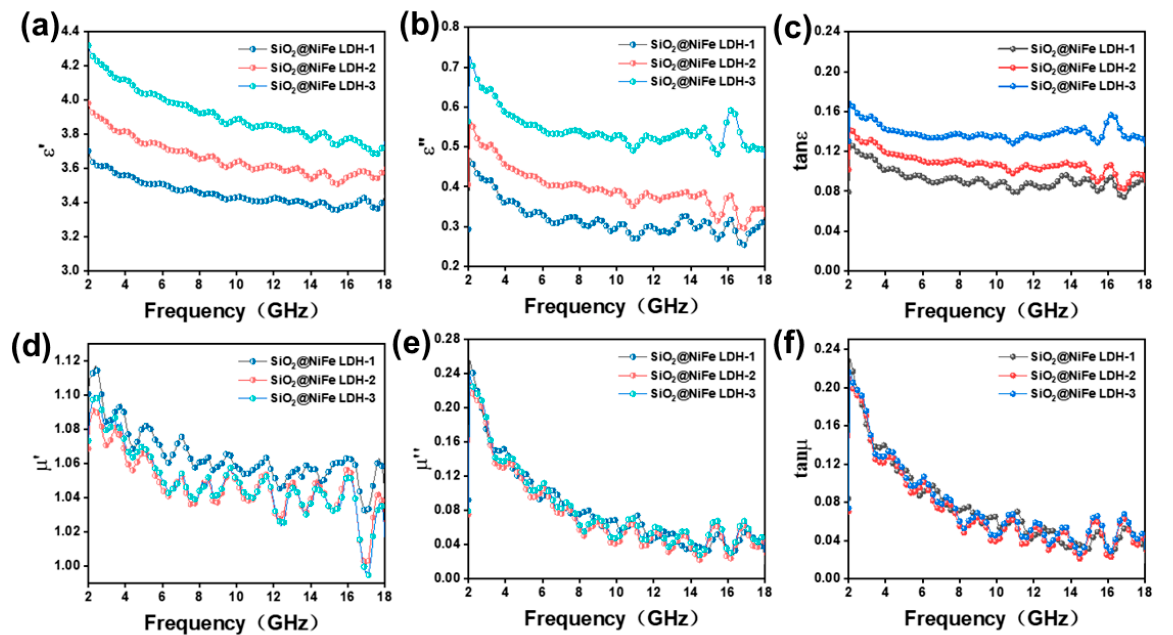
Figure 3. Frequency dependence of ( a ) the real and ( b ) the imaginary part of the complex dielectric constant, ( d ) the real part of the complex permeability and ( e ) the imaginary part, ( c ) Tan ε and ( f ) Tan µ . of the three SiO 2 @NiFe LDH-1, 2, 3 with different Ni, Fe molar ratios.